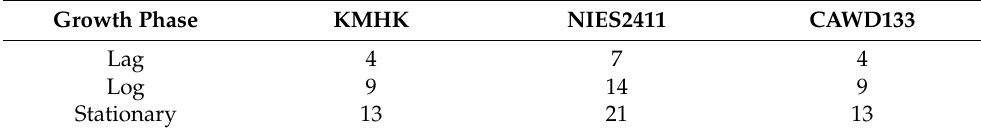
Table A2. Corresponding days for algal cells harvesting of each strain at different growth phases.